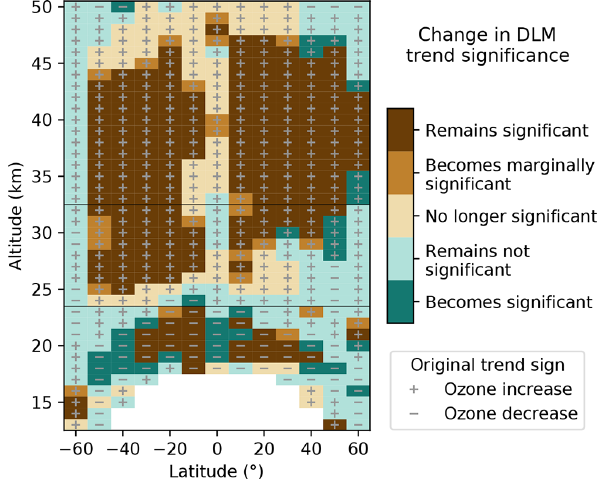
Figure 4. Change in the significance of the 2000–2021 DLM ozone trends when using the adjusted trend distributions for the confidence interval calculation. Brown (green) colors indicate that the DLM trends are originally significant (not significant) with 95% confi- dence. Different shades show if and how the significance changes. Marginally significant indicates trends with 90%–95% confidence.